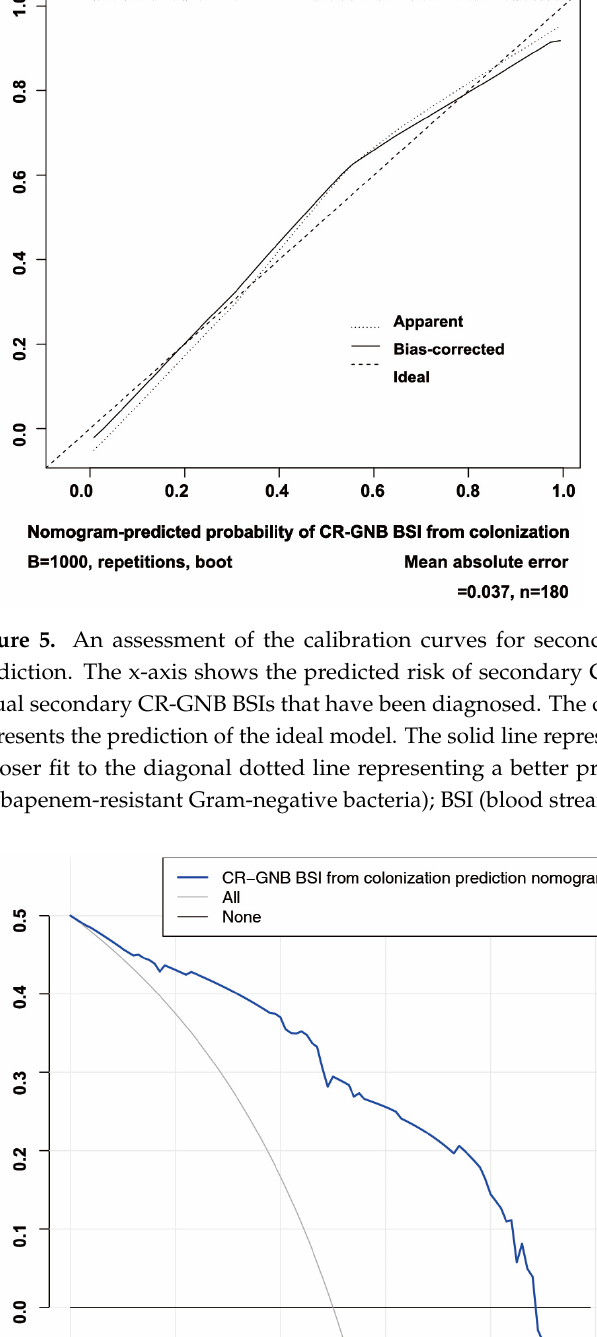
Figure 6. The decision curve of the secondary CR-GNB BSI risk nomogram is analyzed. Net benefit is measured on the y-axis. The dotted line represents the BSI risk nomogram for CR-GNB. In this graph, the thin solid line indicates that all patients have secondary CR-GNB BSI. The thick solid line represents the assumption that no secondary CR-GNB BSI has occurred in any patient. Based on the decision curve, if the patient’s threshold probability was between 1% and 95%, using this model to predict secondary CR-GNB BSI would result in a greater net benefit for the patient. Abbreviations: CR-GNB (carbapenem-resistant Gram-negative bacteria); BSI (blood stream